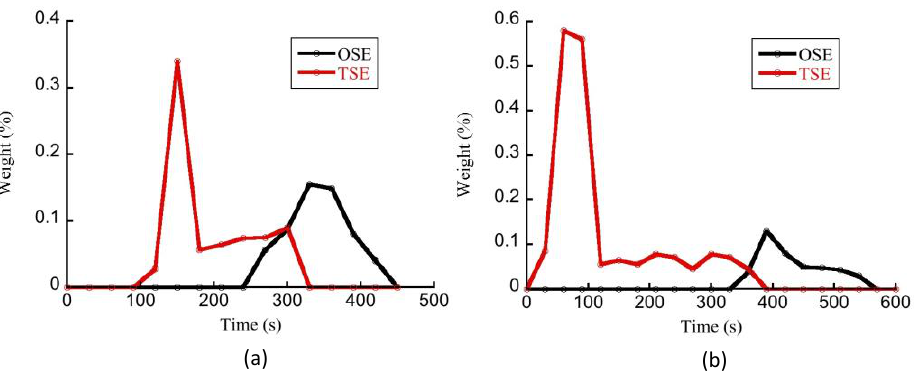
Figure 10. Residence time distribution along the screws of OSE and TSE operated at ( a ) Q/N = 0.0035 (200 rpm) and ( b ) Q/N = 0.0073 (100 rpm).